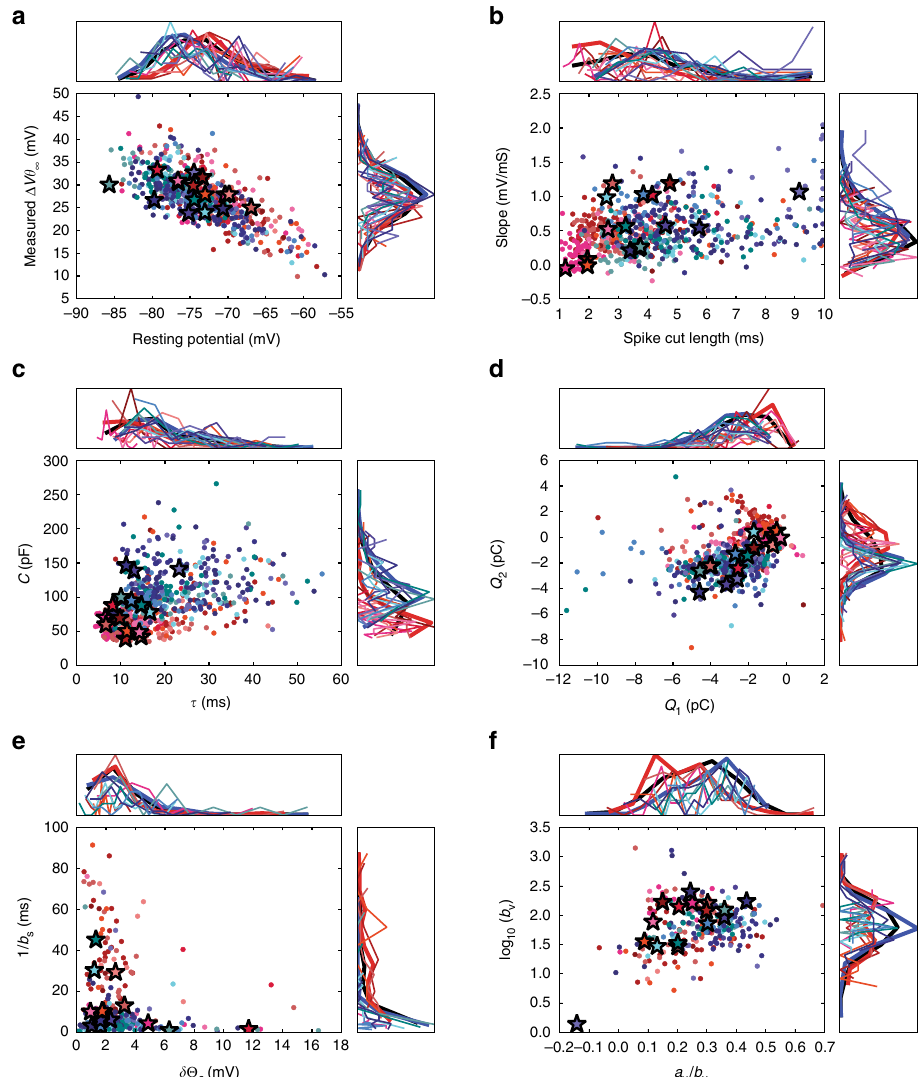
Fig. 3 Slices from the parameter space fi t from electrophysiological data. Detailed parameter fi tting methodology (Fig. 2) is available in the Supplementary Methods. Stars denote example neurons listed in the main text. a Resting potential is measured as the average voltage during rest before training noise (noise 1) current is injected. The threshold relative to rest, Δ V , is measured by subtracting resting voltage from the threshold obtained from the supra- threshold short square pulse. b The spike waveform is removed from the voltage trace by aligning all spikes and fi tting a line to the voltage before and after a spike. The best fi t line within a window of 10 ms after spike initiation was chosen (Supplementary Fig. 1). This spike cut length is used in all models, and voltage measurements before and after a spike are used to reset voltage in ( GLIF 2 , GLIF 4 , and GLIF 5 ). c Capacitance and resistance are fi t via linear regression to sub-threshold voltage (Supplementary Fig. 2). The membrane time constant, τ = RC is plotted. d Total charges of the fast, Q 1 , and slow, Q 2 , after-spike currents deposited each time there is a spike. e The amplitude, a s , and decay, b s , of the spiking component of the threshold, Δ s , (used in GLIF 2 , GLIF GLIF fi t to the triple short square data set (Supplementary Fig. 3). f In the GLIF fl uenced by the voltage of the neuron 4 , and 5 ) is 5 , the threshold is in according to (Equation 4). The two parameters of Eq. 4 are plotted here. Colors in all panels correspond to transgenic lines illustrated in Fig.